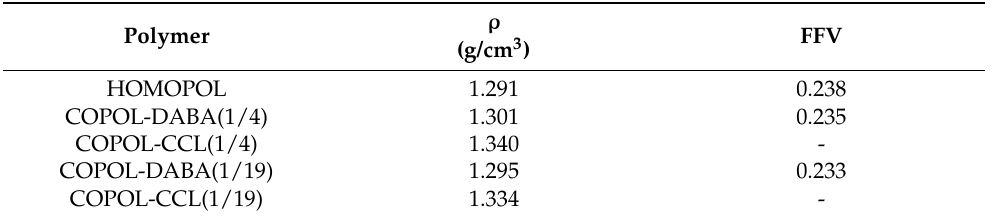
Table 5. Film densities of homopolyimide, copolyimides, and crosslinked polyimides. Fractional free volumes (FFV) of homopolyimide and